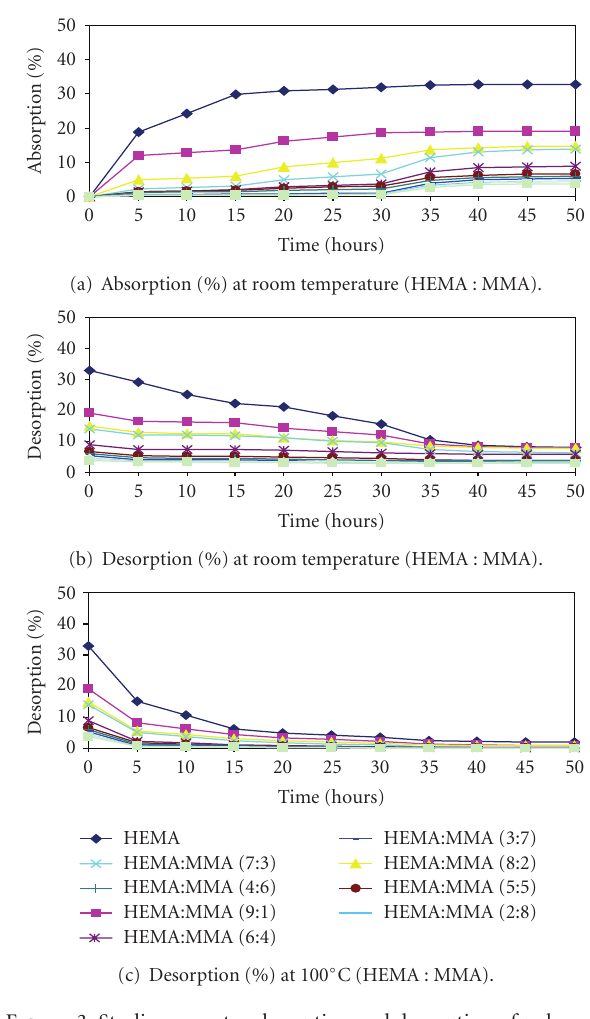
Figure 3: Studies on water absorption and desorption of polymers obtained with HEMA :